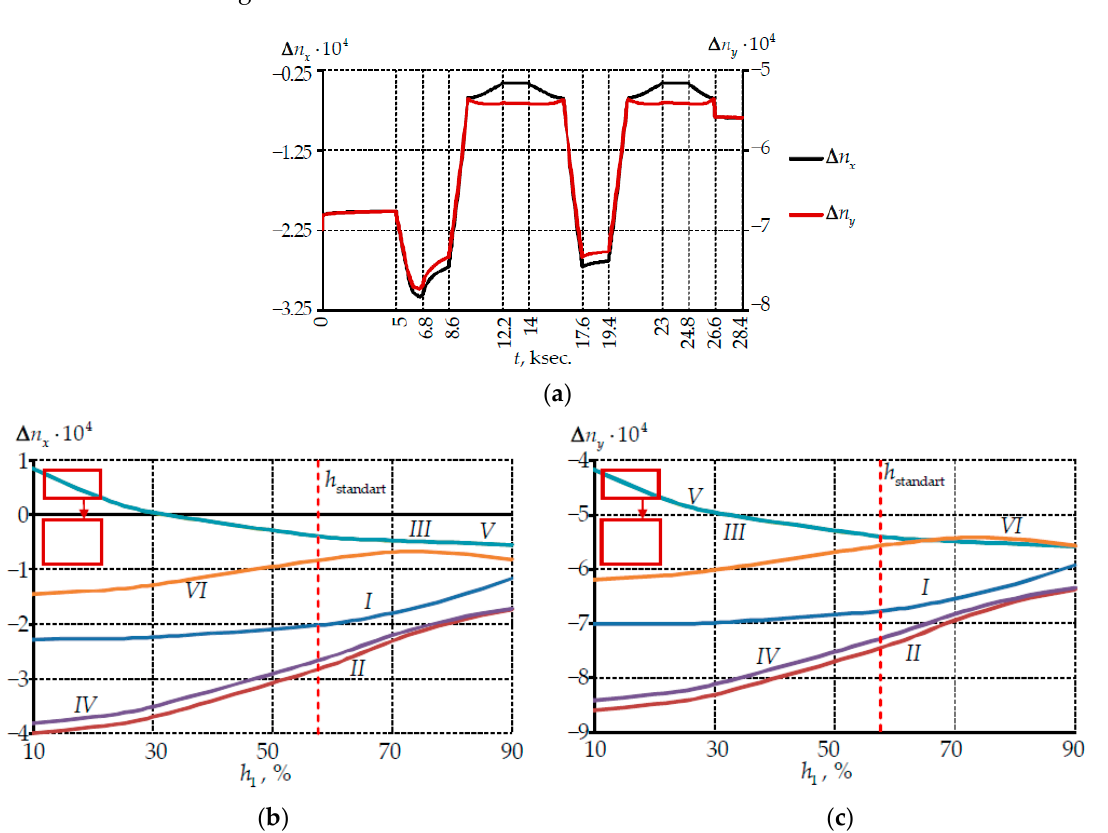
Figure 9. Deviations of the refractive indexes in the light-conducting core center: ( a ) evolution of parameters within the thermal cycle; ( b ) dependence of ∆ n x on the PC thickness; ( c ) dependence of ∆ n y on the PC thickness; I–VI are numbers of holding zone at constant temperature; I is 23 ◦ C; II is 60 °C; III is − 60 °C; IV is 60 °C; V is − 60 °C; VI is 23 °C.